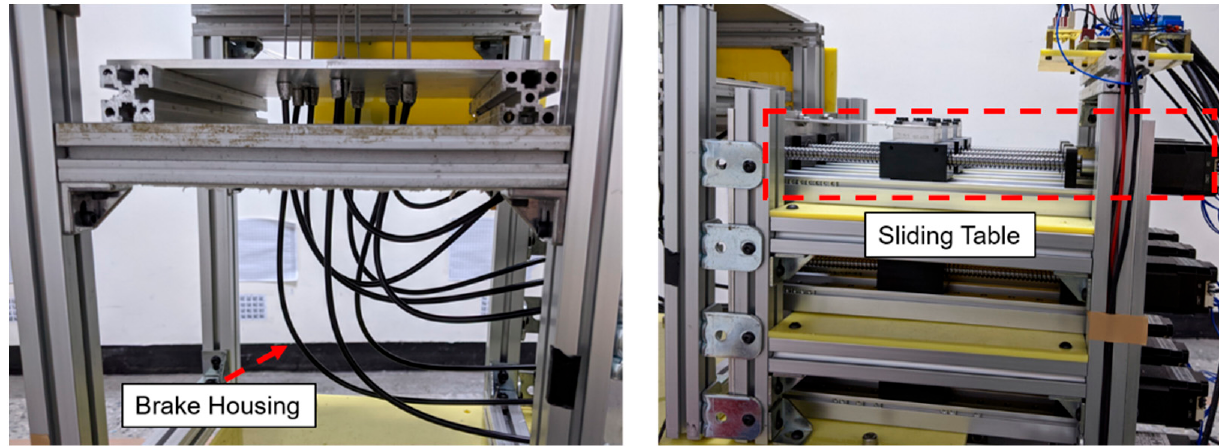
Figure 10. The brake housings ( left ) and a single sliding table ( right ).